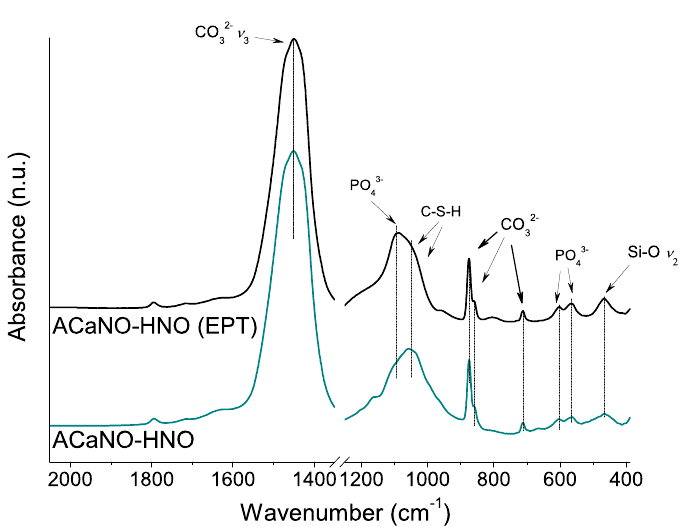
Figure 12. FT-IR analysis of hydrated BEC surface after 7 days SBF essay: without post-synthesis treatment (ACaNO-HNO), and after EPT (ACaNO-HNO (EPT)).